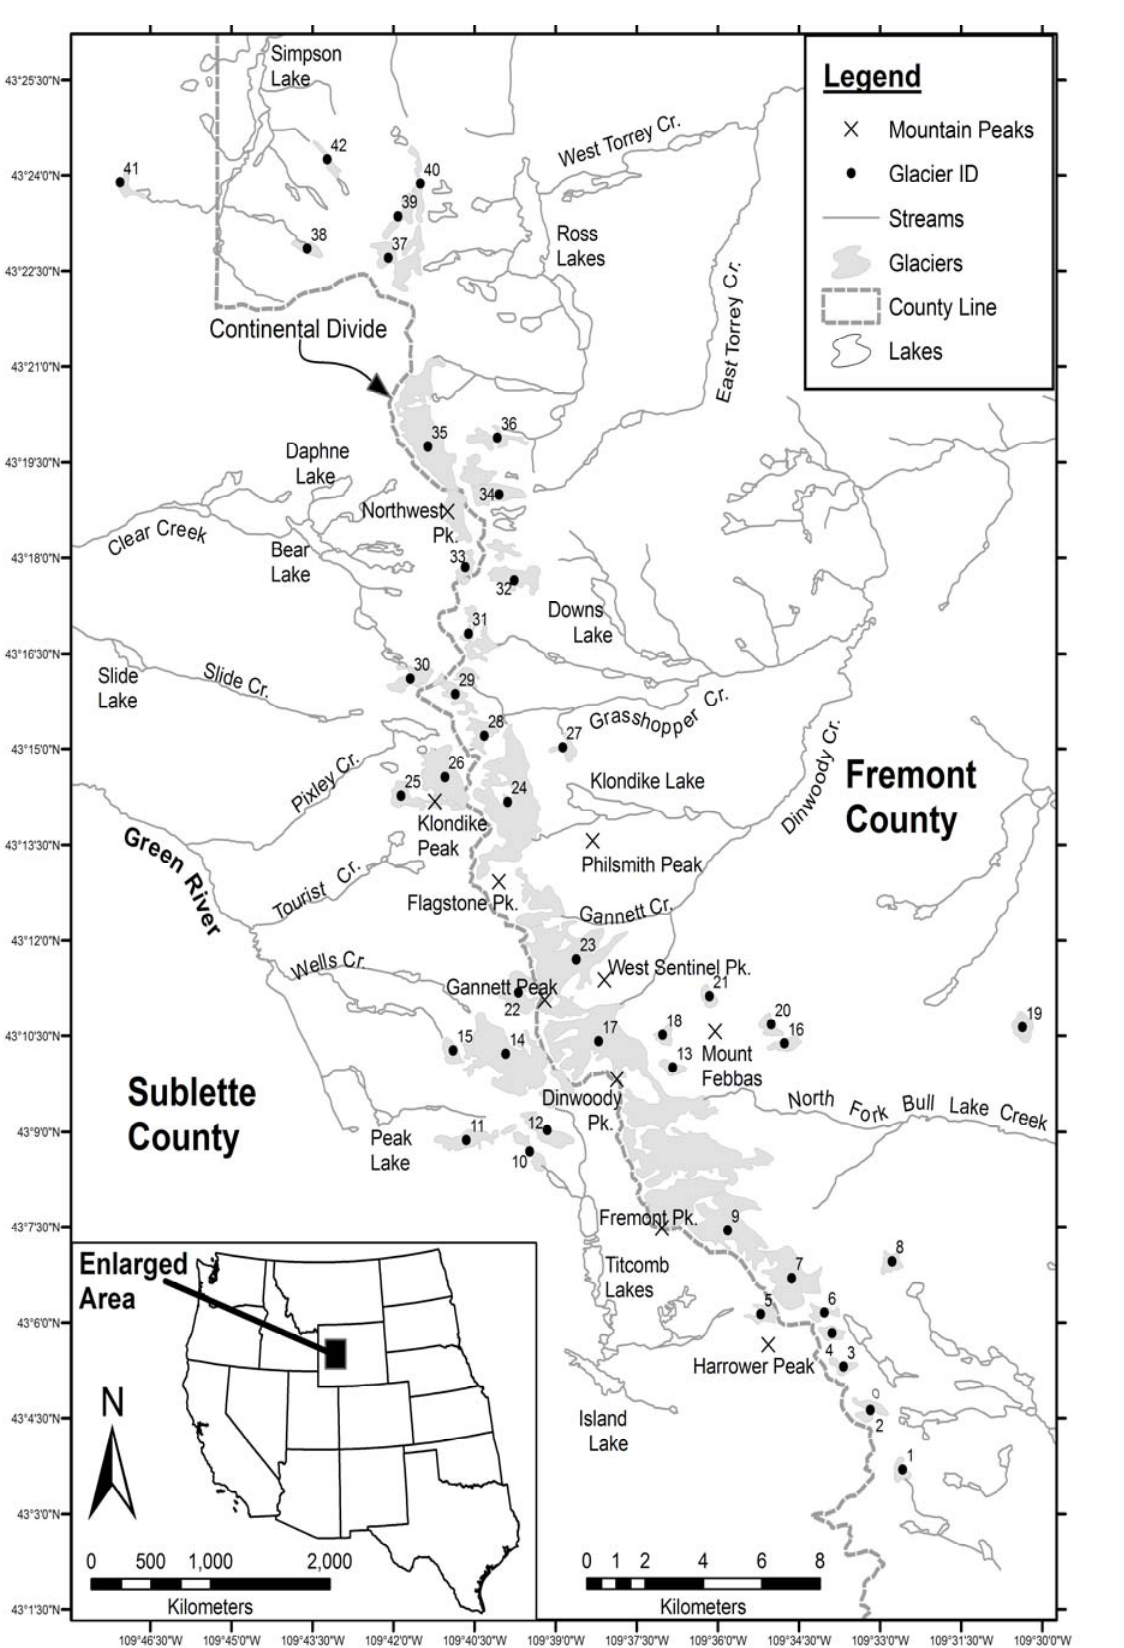
Figure 1. Location Map of glaciers in the Wind River Range, Wyoming,